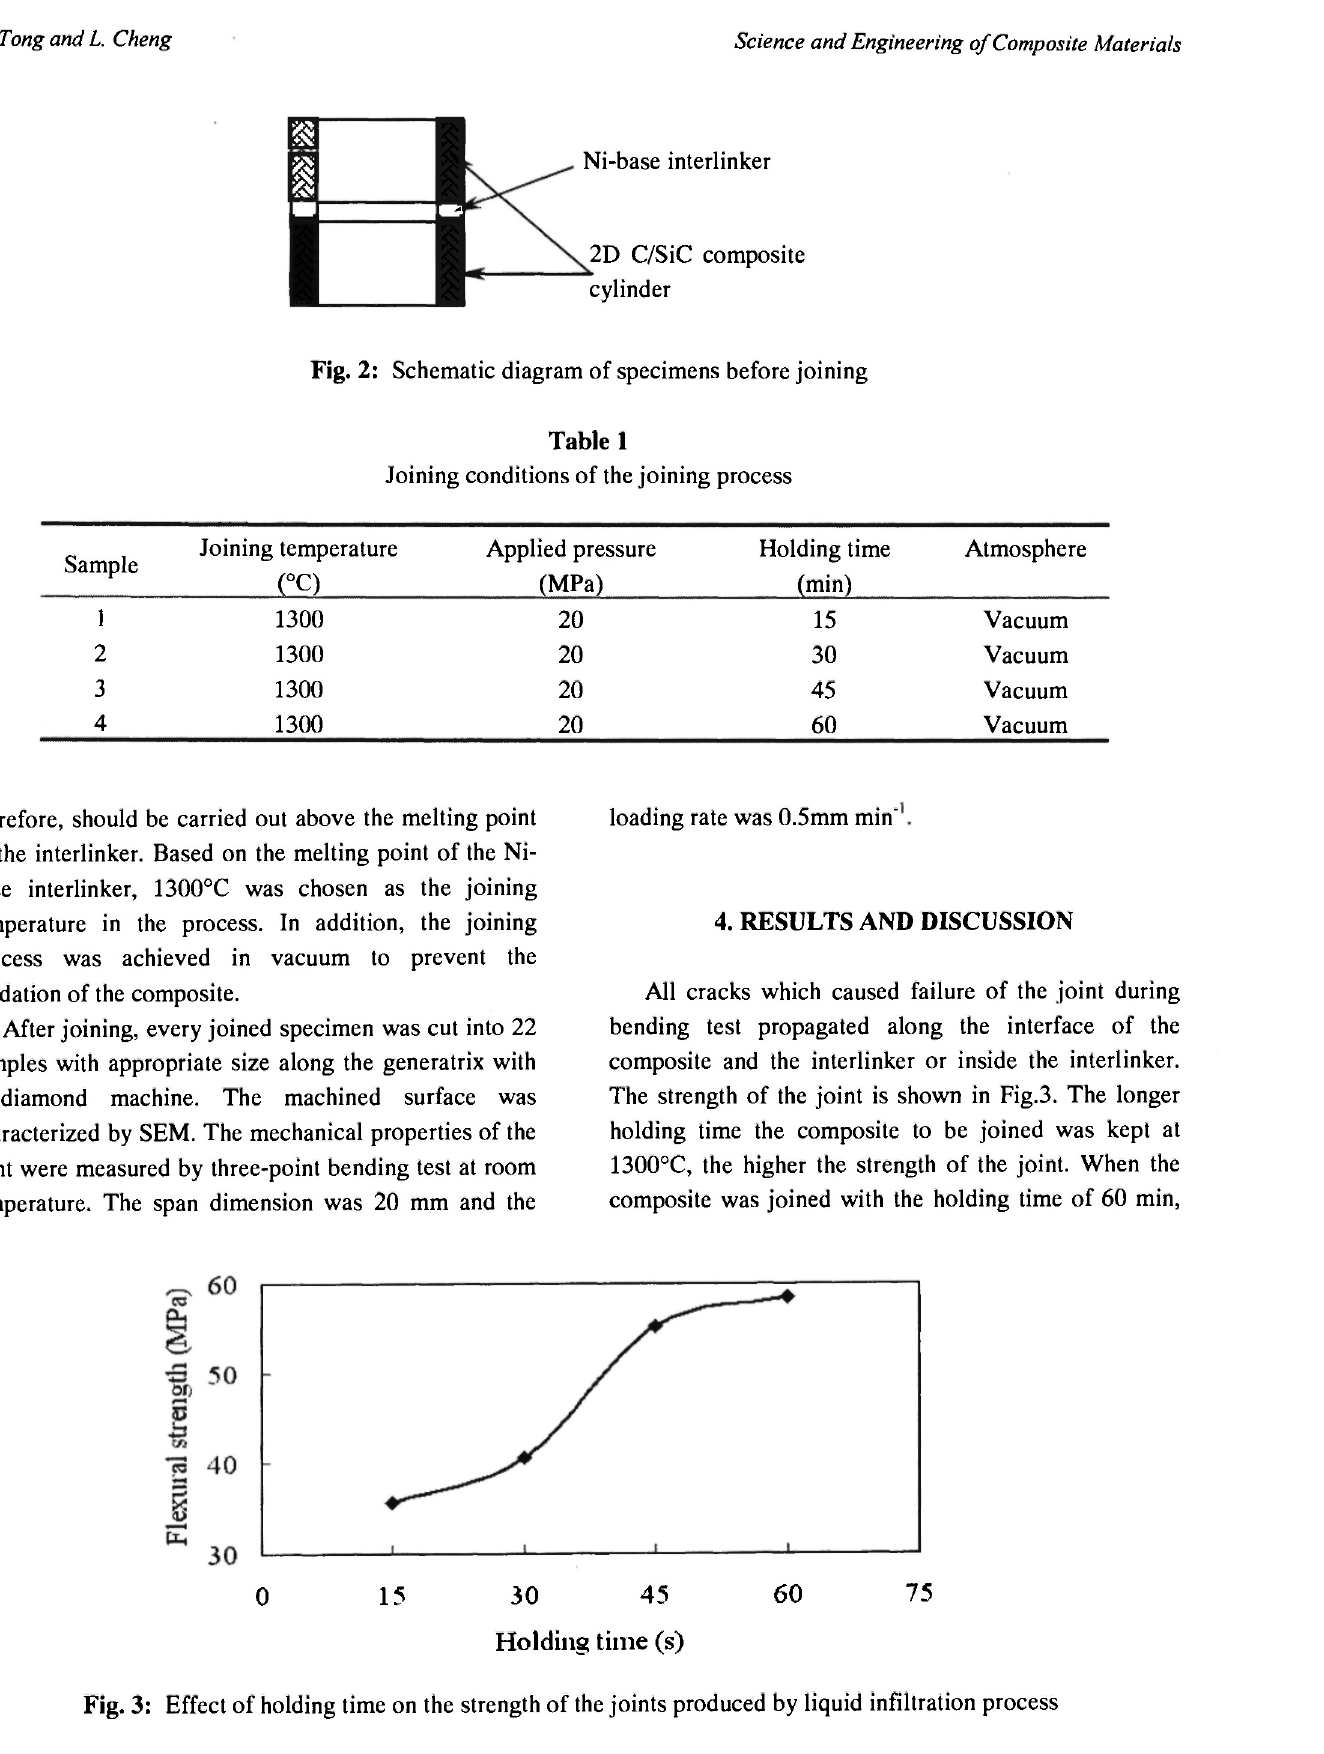
Fig. 3: Effect of holding time on the strength of the joints produced by liquid infiltration